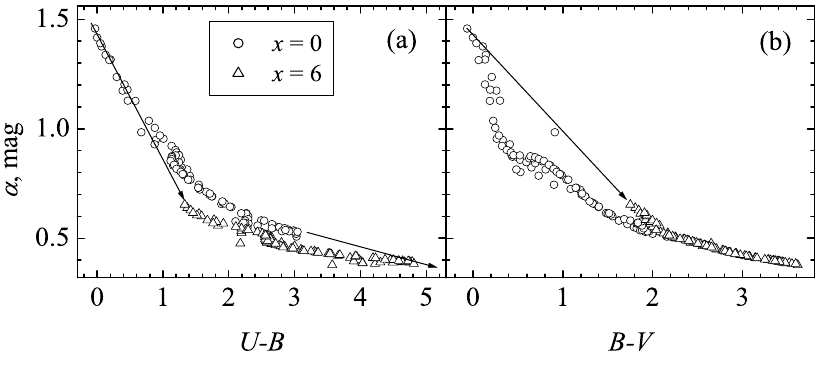
Fig. 3. Dependence of the extinction coefficient α on color indices U–B (a) and B–V (b) in the UBV photometric system for unreddened ( x = 0) and reddened ( x = 6) stars. Arrows show the moving direction of stars when the mass of interstellar dust x increases from 0 to